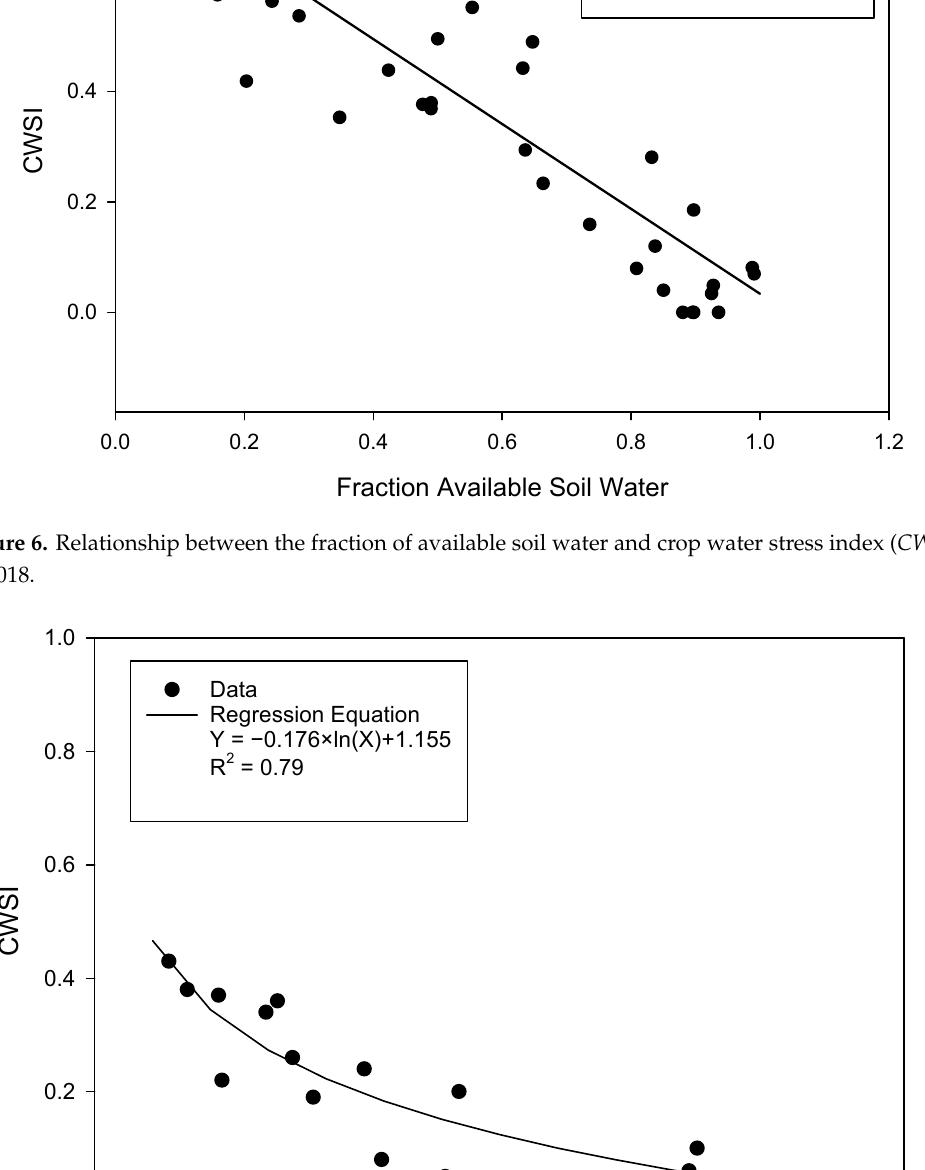
Figure 7. Relationship between the seasonal irrigation applied and seasonal average daily crop water stress index ( CWSI ) for Malbec over the 5-year study at the experimental site.